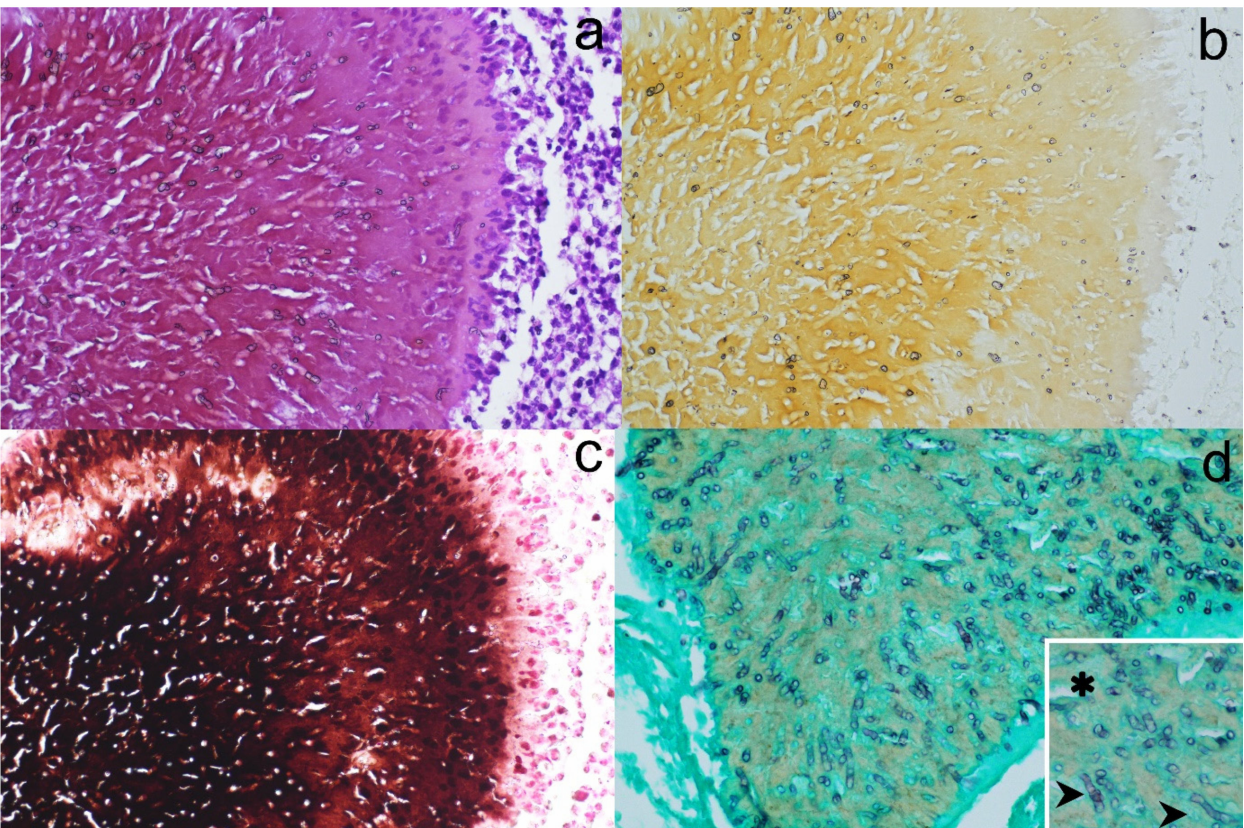
Figure 2. Histopathology and histochemistry of granules. HE stain ( a ) shows the presence of hyphal aggregates within the granules; unstained ( b ) and Fontana–Masson-stained ( c ) sections show the presence of a faint brownish pigment ( b ) or a very dark melanized background within the granules; Grocott staining ( d ) allows better definition of hyphal characteristics; short hyphae (arrows) and cystic dilations (asterisks) are indicated in the